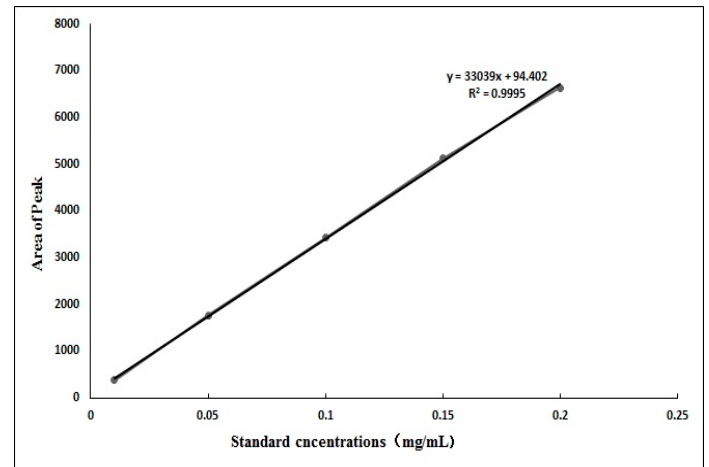
Figure 3. Standard linear regression curve. Nutrients 2022 , 14 , x FOR PEER REVIEW